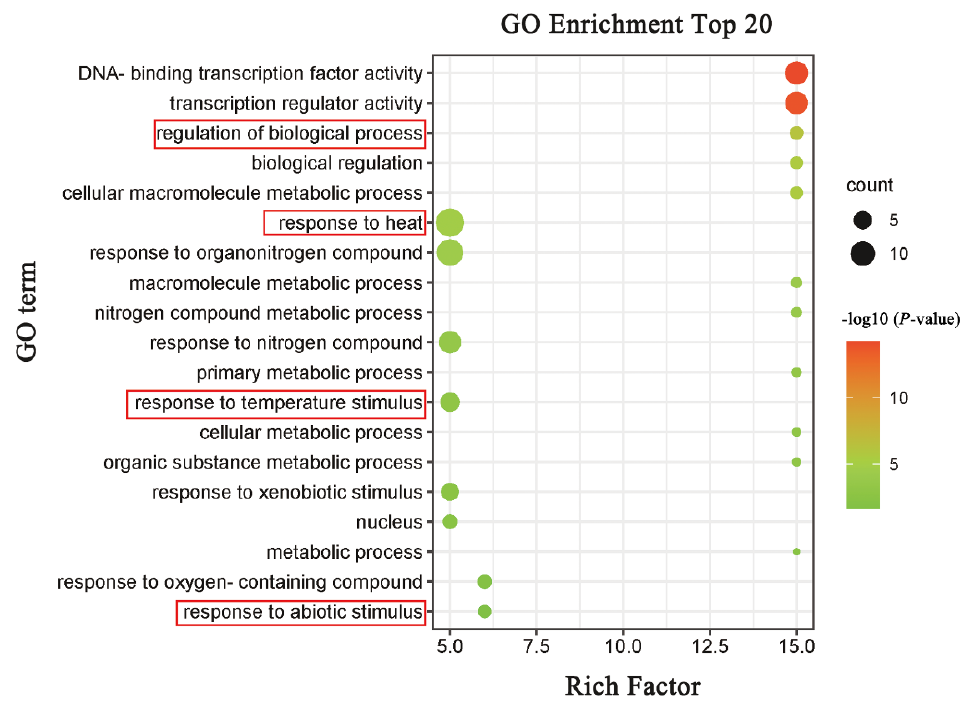
Figure 11. GO enrichment analysis of the MsHSF proteins relative to the GO database. The horizontal axis indicates the enrichment factor, and the size of the circle indicates the number of genes annotated with a given GO term.